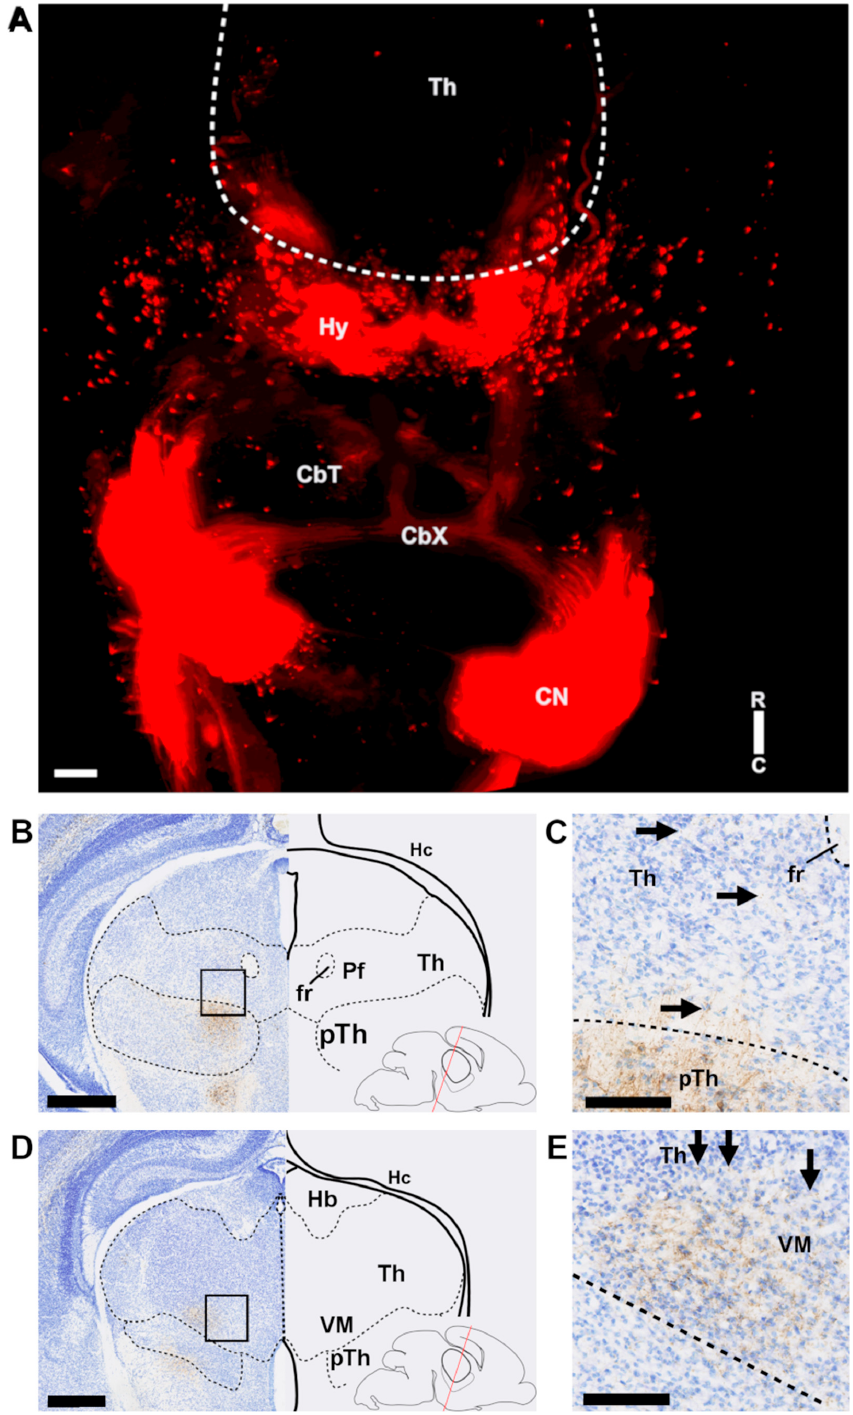
Figure 3. RFP + fibers in the diencephalon at E17.5. ( A ) Horizontal view of a maximum intensity projection of a 3DISCO cleared E17.5 mouse brain. Compass in bottom right indicating directions of rostral (R) and caudal (C) sides. ( B – E ) Coronal section of an E17.5 mouse brain, where ( C , E ) are zoomed in on the boxes in ( B ) and ( D ), respectively. In the bottom right of ( B , D ), schematic showing the angle and rostro-caudal level of the coronal slices. Fibers can be seen in the Th, though they are much less bundled than in the medial pTh. Scale bars: ( A ) = 100 µ m; ( B , D ) = 250 µ m; ( C , E ) = 100 µ m. CbT = cerebellothalamic tract, CbX = decussation of the cerebellar tract, CN = cerebellar nuclei, fr = fasciculus retroflexus, Th = thalamus, pTh = prethalamus, Hc = hippocampus, Hb = habenula, Pf = parafascicular nucleus, VM = ventromedial